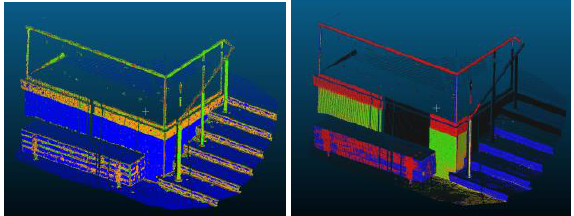
Figure 3: TLS Curvature (Left) and Intensity (Right) k-means